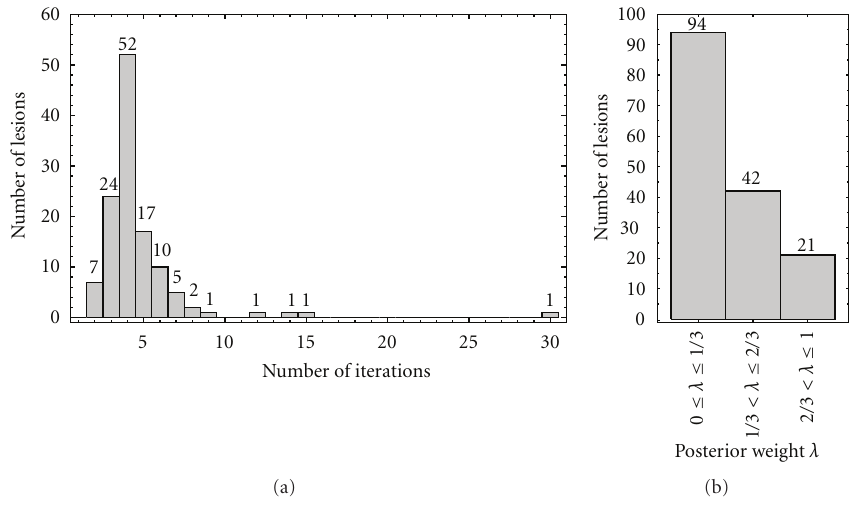
Figure 7: (a) Number of iterations for convergence and the (b) frequencies of the automatically selected value for the weight λ showing how the LDA ( λ = 0) and QDA ( λ = 1) posteriors where combined according to (1) in the proposed ICS algorithm. Results are summarized according to three intervals of possible λ